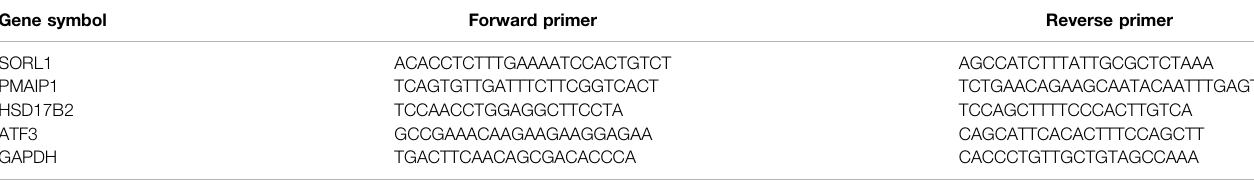
TABLE 1 | mRNA primer sequences.